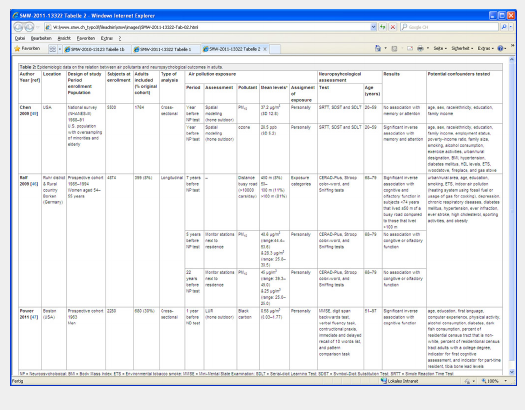
Epidemiologic data on the relation between air pollutants and neuropsychological outcomes in